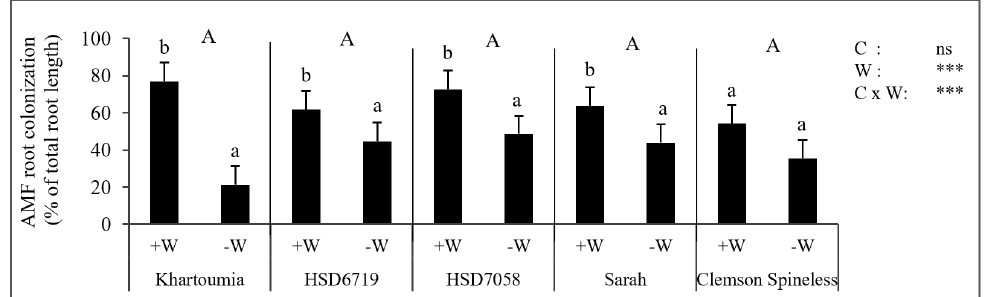
Figure 2. AMF colonized root length in percent of the total root length at the time of harvest of the five tested cultivars. Substrate water content was either maintained at 20% (+W) or reduced to 10% w/w (−W). Asterisks indicate significant differences in the cultivar (C), substrate water content (W) and their interaction (Kruskal-Wallis test, n = 4, p < 0.05 (*), p < 0.01 (**), p < 0.001 (***) and p > 0.05 (ns)). Shown are mean values ± standard deviation. Within each cultivar, the mean values followed